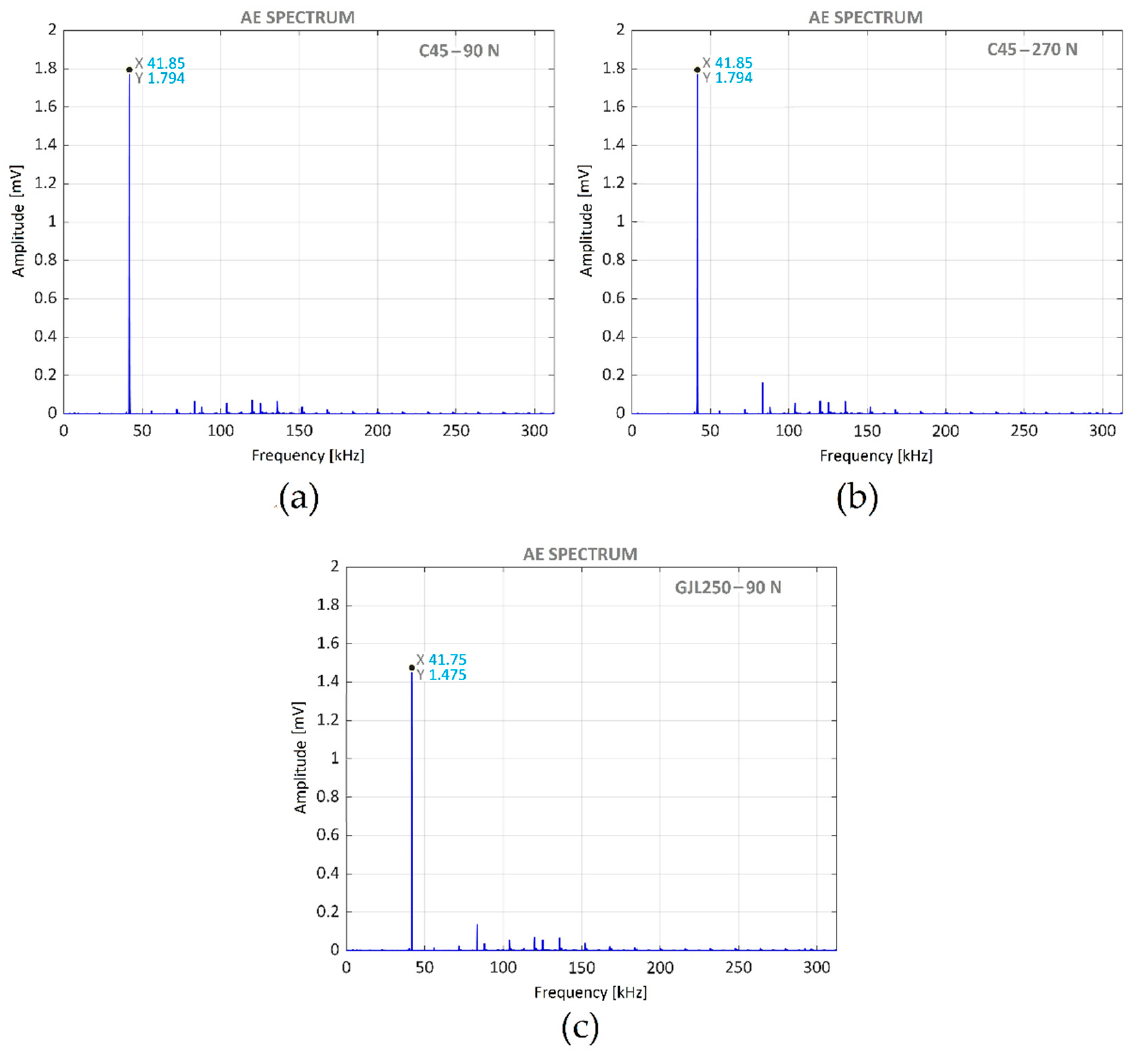
Figure 14. AE spectra corresponding to different VABB: ( a ) C45 steel with 90 N; ( b ) C45 steel with 270 N; ( c ) GJL250 cast iron with 90 N.